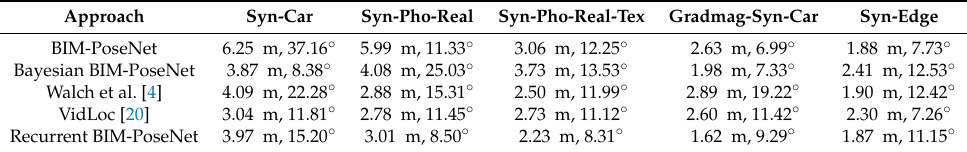
Table 2. The comparison of the errors of different approaches for the five synthetic image datasets being tested using real images. DSAC++ [16] did not converge for all the synthetic datasets in spite of containing 2500 training images.